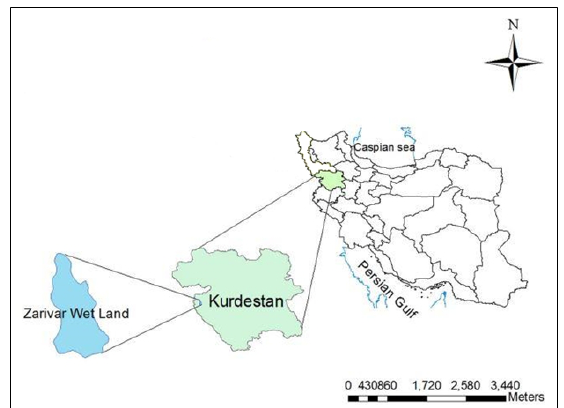
Figure 1.The map of Zarivar wetland in western Iran